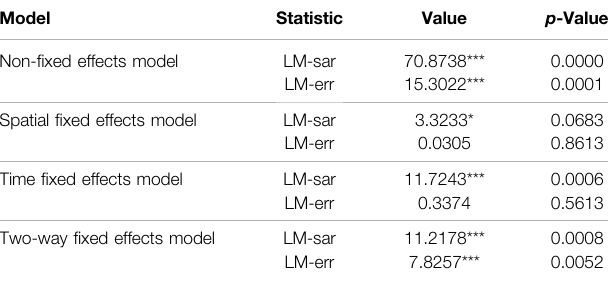
TABLE 5 | Lagrange multiplier (LM) statistics under different fi xed effects.